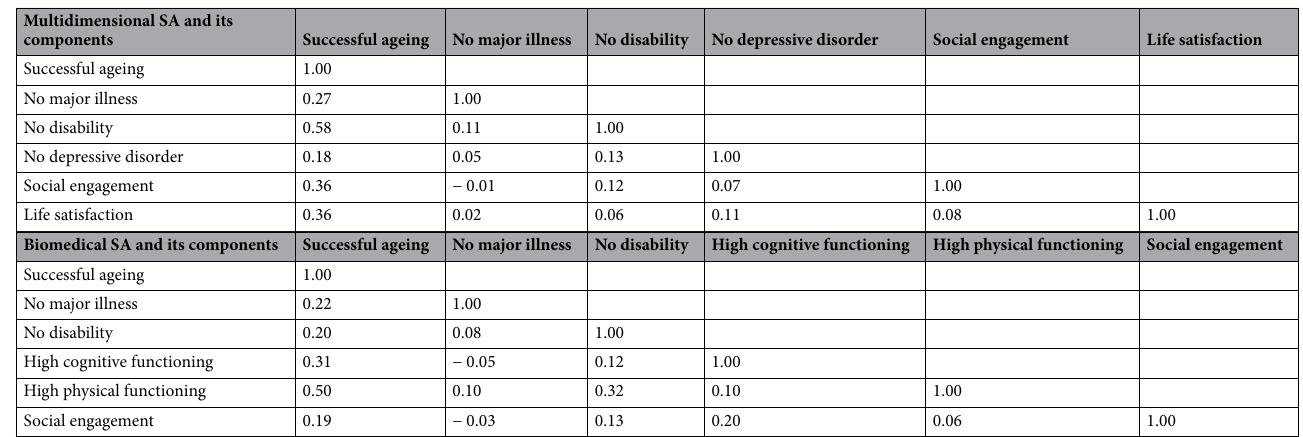
Table 3. Correlations between successful ageing